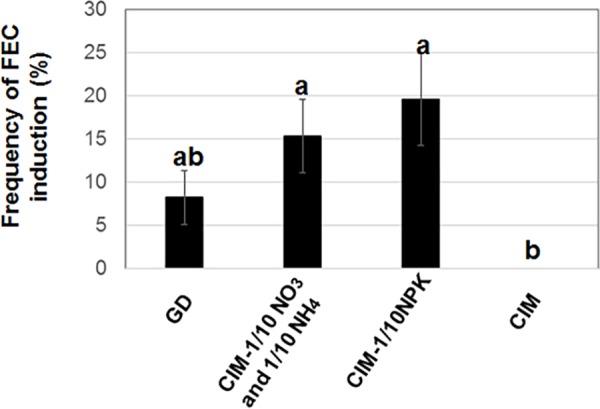
Effect of CIM-Ρ NPK on FEC production.Means and standard deviation were represented as five independent measurements as shown in S3 Table. The number of buds represented as the number of AB transferred to CIM. All FEC induced from one bud was counted as one FEC. The frequency of FEC formation was estimated as number of FEC per number of buds. FEC formation was determined as follows: The tissue like FEC and non-FEC on media were separately transferred to fresh FIM. The friable appearance as shown in Fig 8F was counted as FEC. CIM-Ρ NPK was composed of CIM with reduced content of nitrogen, phosphate, and potassium. Values labeled with different letters (a and b) at all conditions are significantly different by Scheff’s multiple comparison tests at P<0.05.